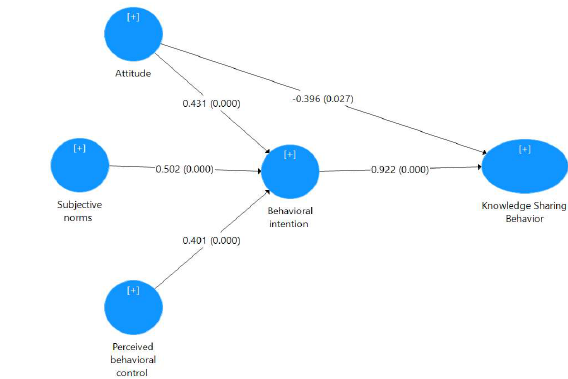
Fig. 4 . Mediate role of Behavioral intention